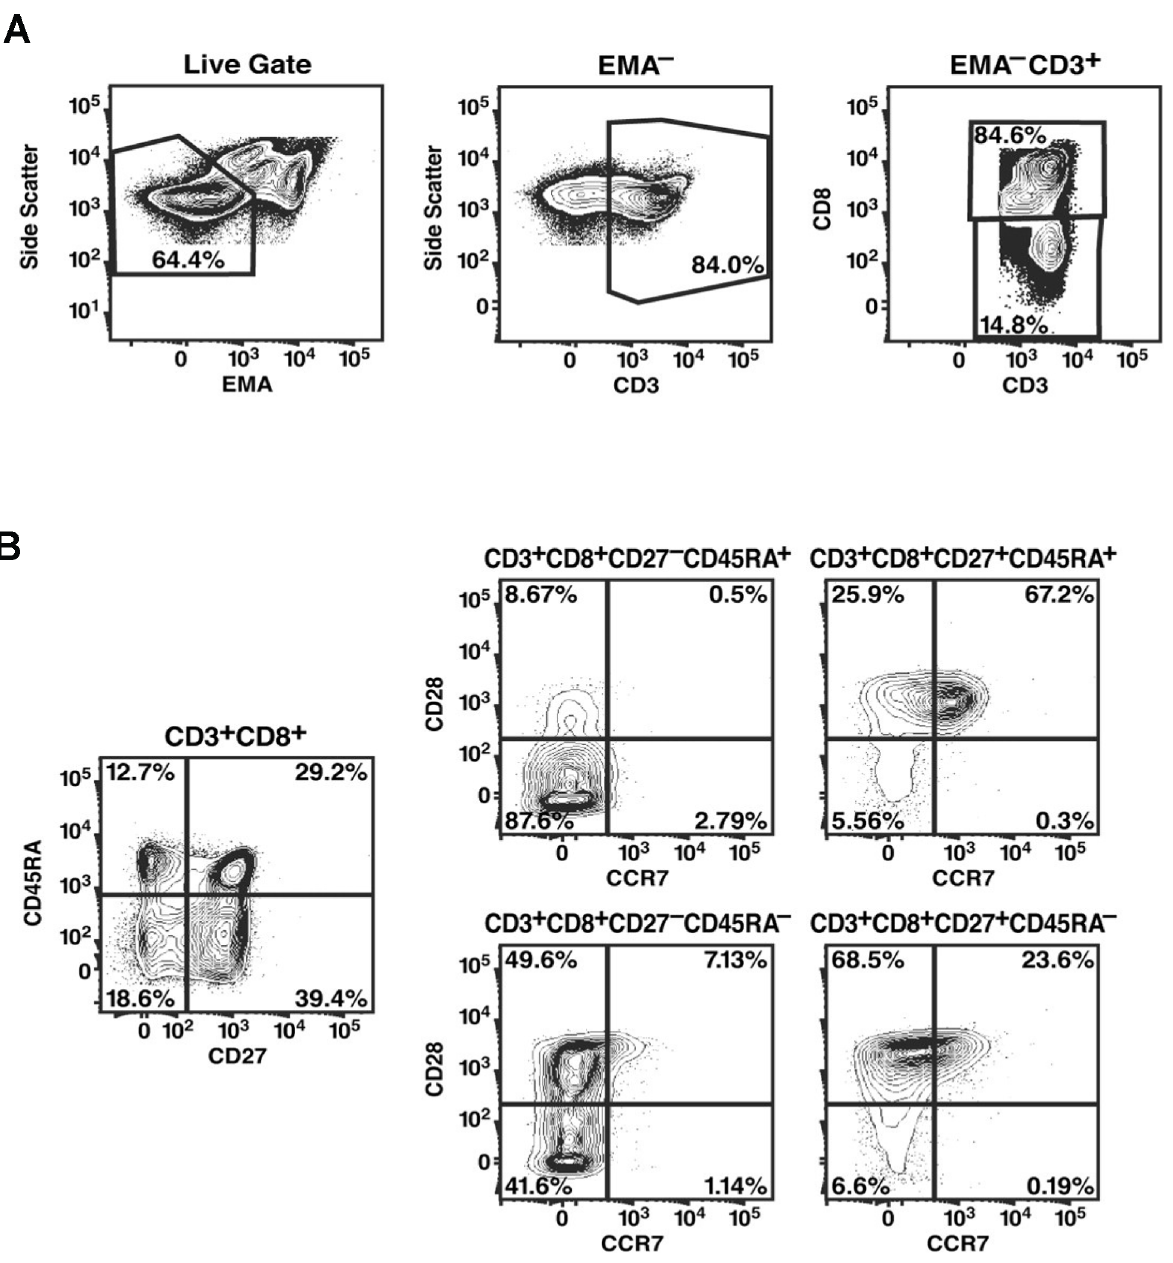
Figure 1. Gating of T cell populations. PBMCs stained and captured by FACSDIVA and analyzed FlowJo software. 1–2 million PBMCs were stimulated and stained, and all events captured for analysis. EMA staining was used to eliminate dead/dying cells from further analysis. EMA 2 T cells were defined by side scatter and then by CD3 expression (A). EMA 2 T cells that were CD3 + CD8 2 or CD3 + CD8 + cells were designated as CD4 + and CD8 + T cells, respectively. The CD4 + and CD8 + T-cell populations were each divided into subpopulations based on their expression of CD45RA, CD27, CD28, and CCR7 (B). Gating utilized Fluorescence Minus One (FMO) strategy.